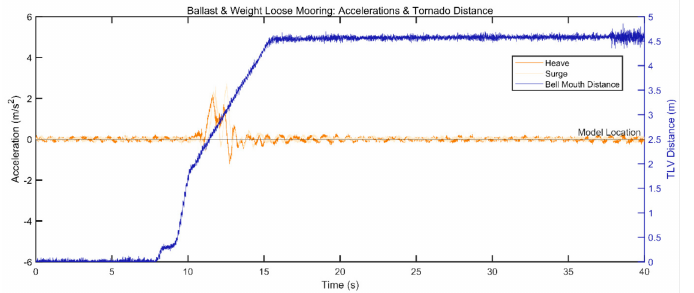
Figure 16. Heave and Surge accelerations and bell mouth distance (Tornado location) for configura- tion